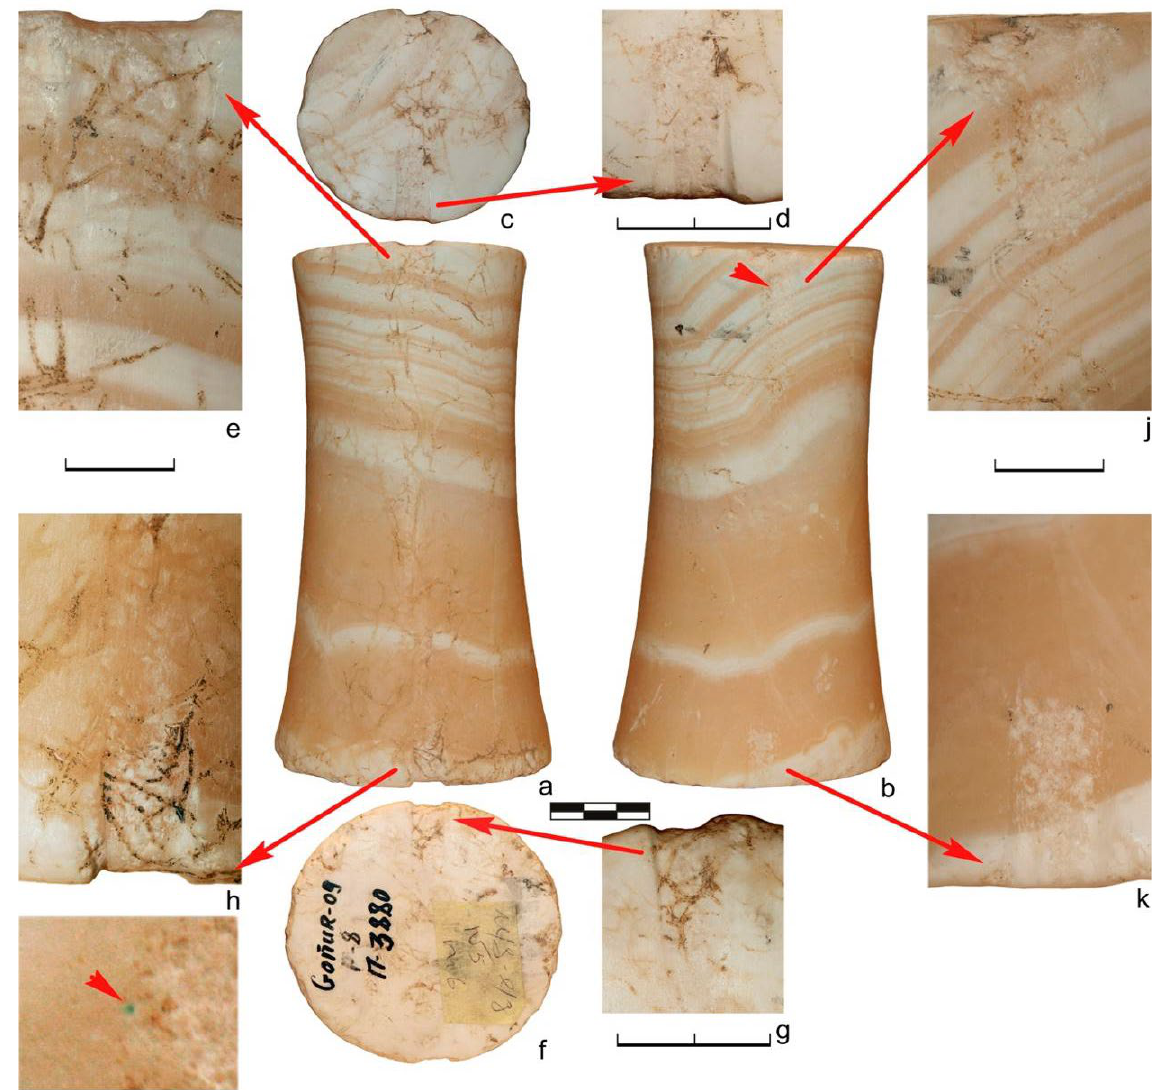
Figure 21. The main technological methods of manufacturing grooves on a miniature column from Gonur Depe (from the depositories of the Art Museum, Ashgabat): a, b. side; c. top base; f. bottom base; e, h, g, j, k. sawing and pecking marks; l. traces of a copper grain. Scale bar is 3 cm long, separated into three 1 cm